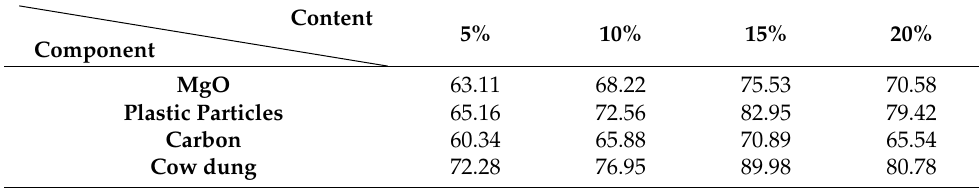
Table 7. Metallization rate of Newman ore with different coating materials and compositions.